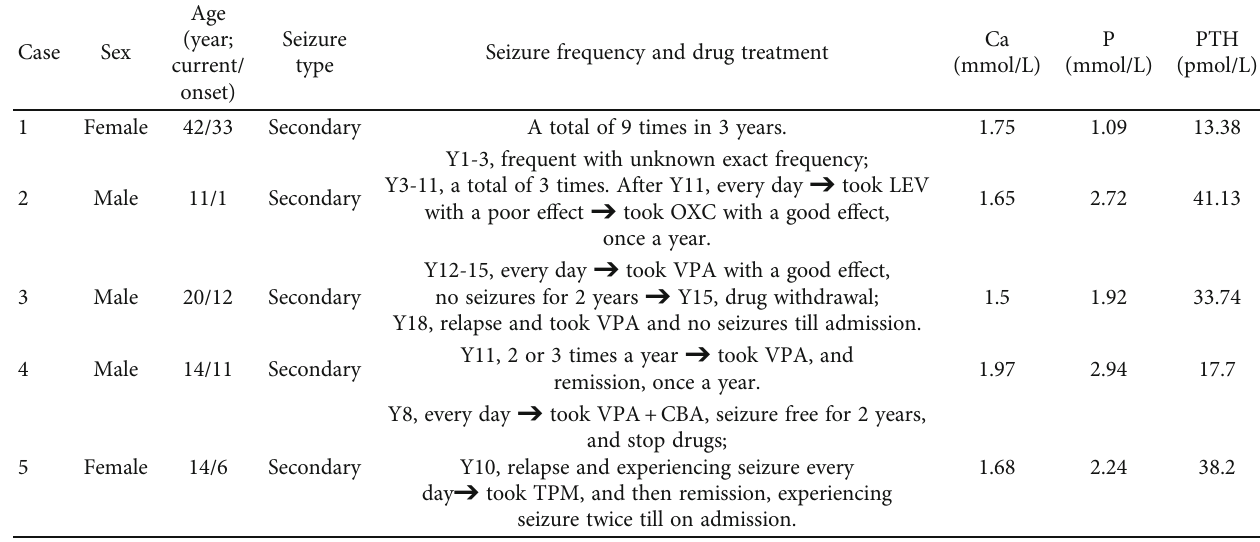
Table 2: Summary of clinical presentations and blood examination.